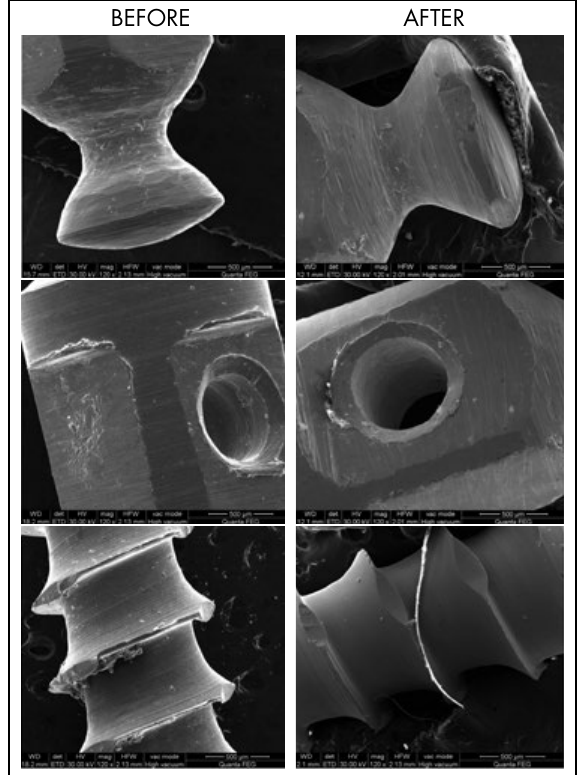
Table III denotes the descriptive statistics of the mean values of Ti, Al and V release of the groups. Group 4 had the highest amount of Ti, Al, and V release when compared to other groups. Aluminium was released from all groups, with Group 3 showing the lowest